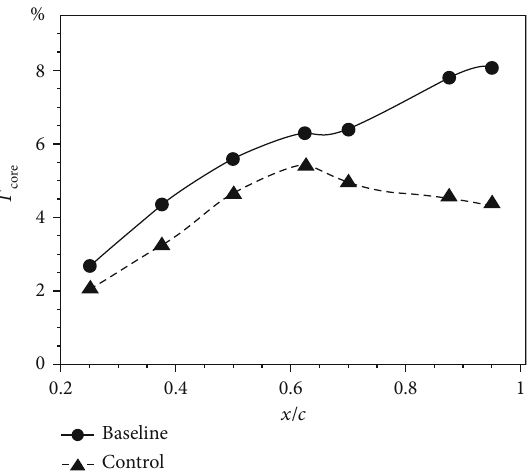
Figure 15: The maximum induced